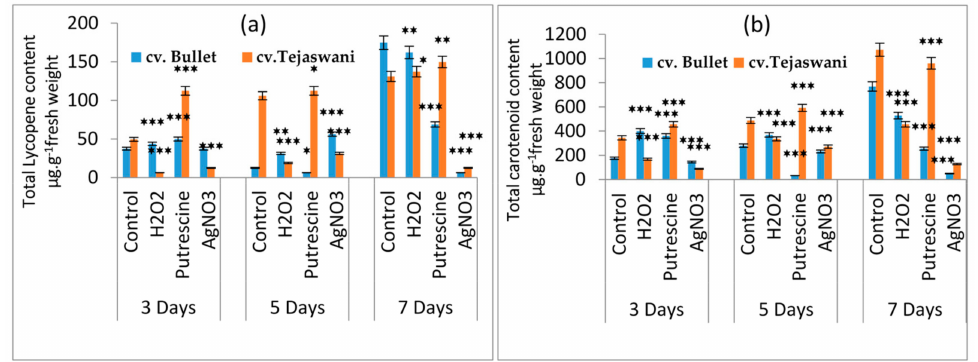
Figure 2. Changes of total lycopene ( a ) and total carotenoid content ( b ) of two chili types, i.e., cv. Bullet and cv . Tejaswani, under di ff erent treatments (Control, H 2 O 2 , putrescine and AgNO 3 ) and durations (3, 5, and 7 days). The vertical bars represent the data with the mean of the three replicates with ± SE ( n = 3) from an individual set of experiments, and significant di ff erences between treatments, as calculated by a student’s t-test marked as * ( p ≤ 0.05) ** ( p ≤ 0.01) *** ( p ≤ 0.001).